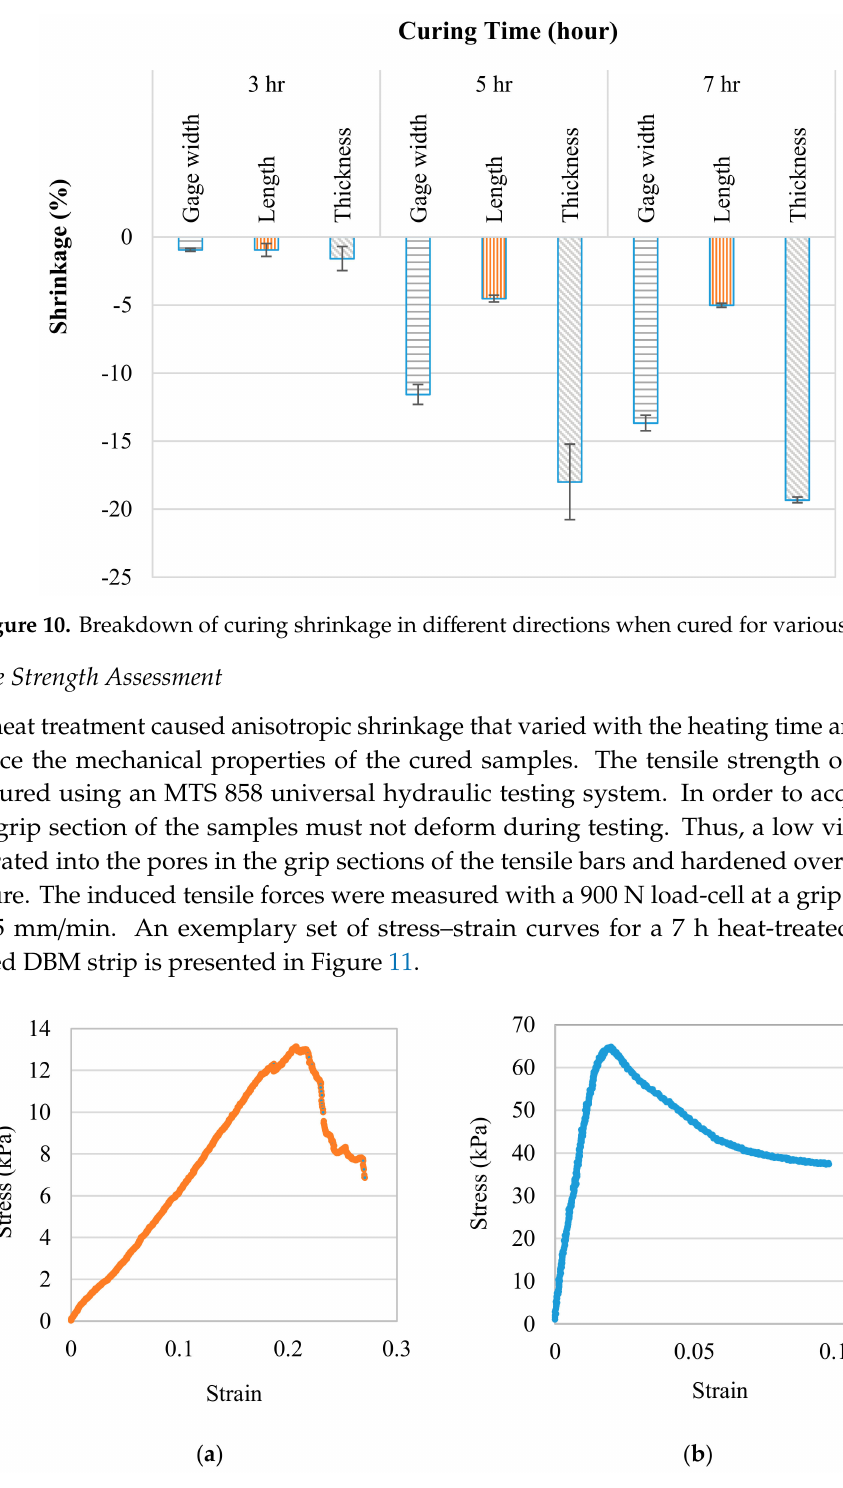
Figure 11. The stress versus strain curve. ( a ). A machined DBM strip. ( b ) A 7 h post-processed